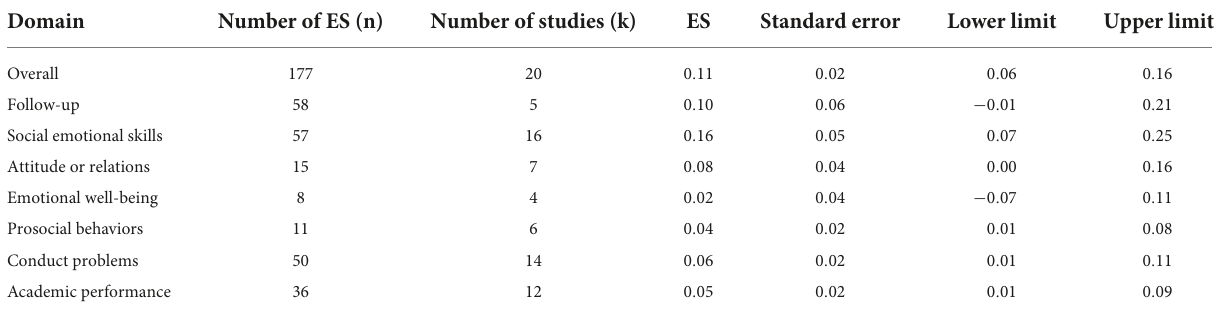
FIGURE2 Forest plots of included studies.